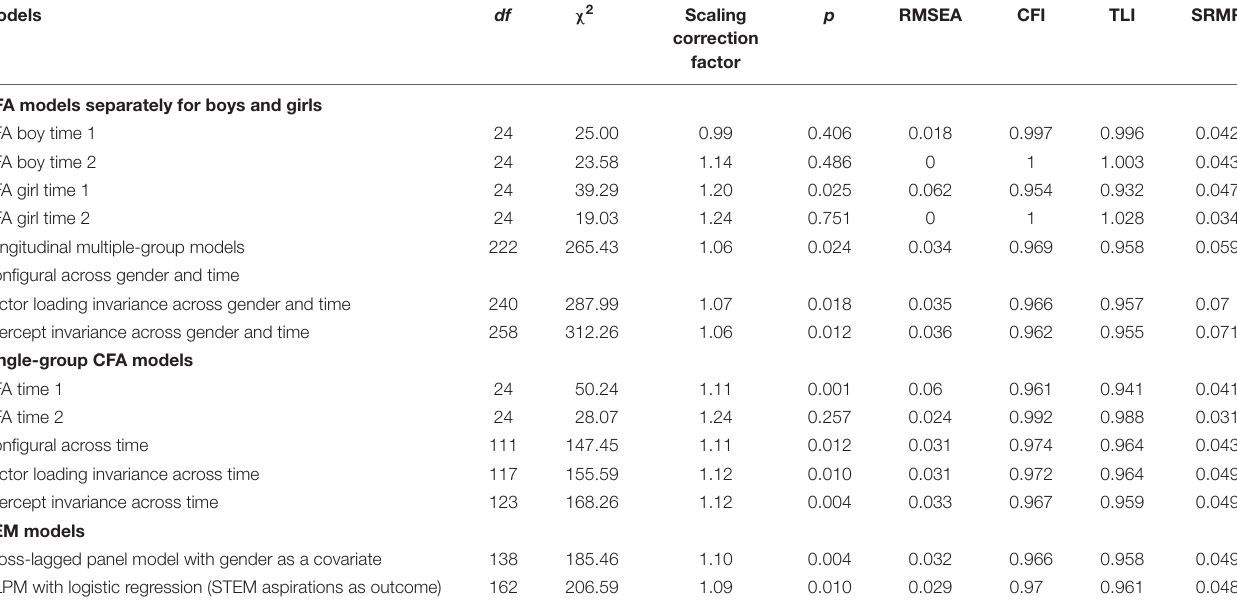
TABLE 3 | Model fit statistics for the longitudinal confirmatory factor analysis (CFA) and structural equation modeling (SEM) models.